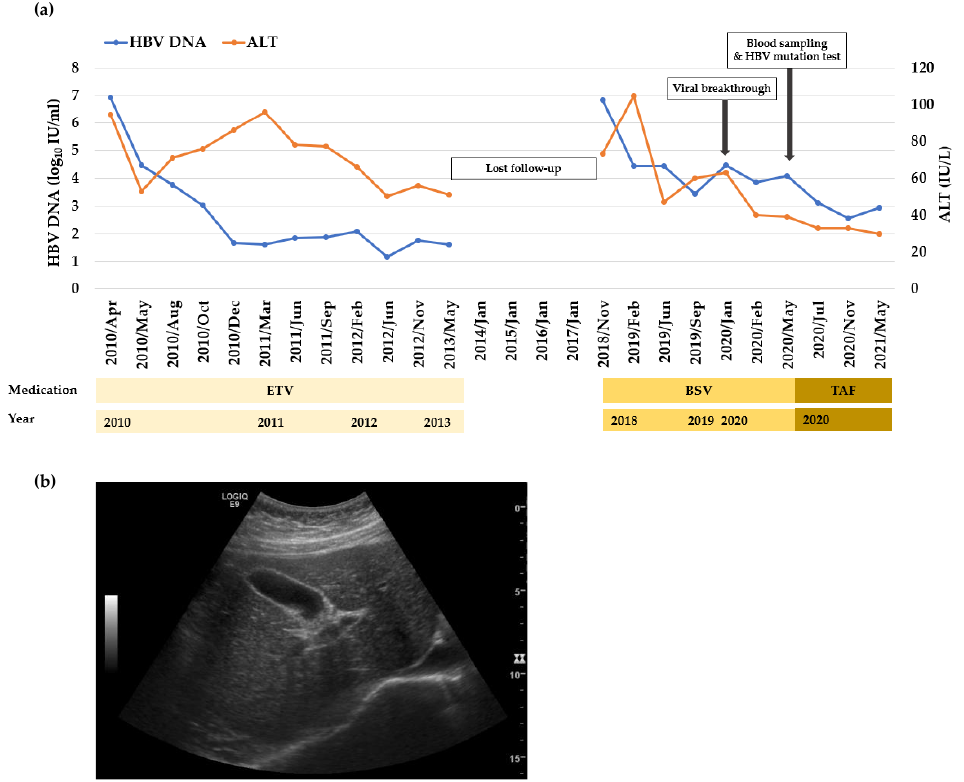
Figure 1. Clinical course and liver ultrasonography of the CHB patient with incomplete virological response during BSV treatment. ( a ) Clinical course during treatment of BSV. The patient first was treated with BSV in December 2018. In May 2020, drug regimen was changed from BSV to TAF. Serum samples were analyzed for HBV-DNA and ALT measurement. The time points of serum sampling are indicated by arrows. ETV, entecavir; BSV, besifovir dipivoxil maleate; TAF,